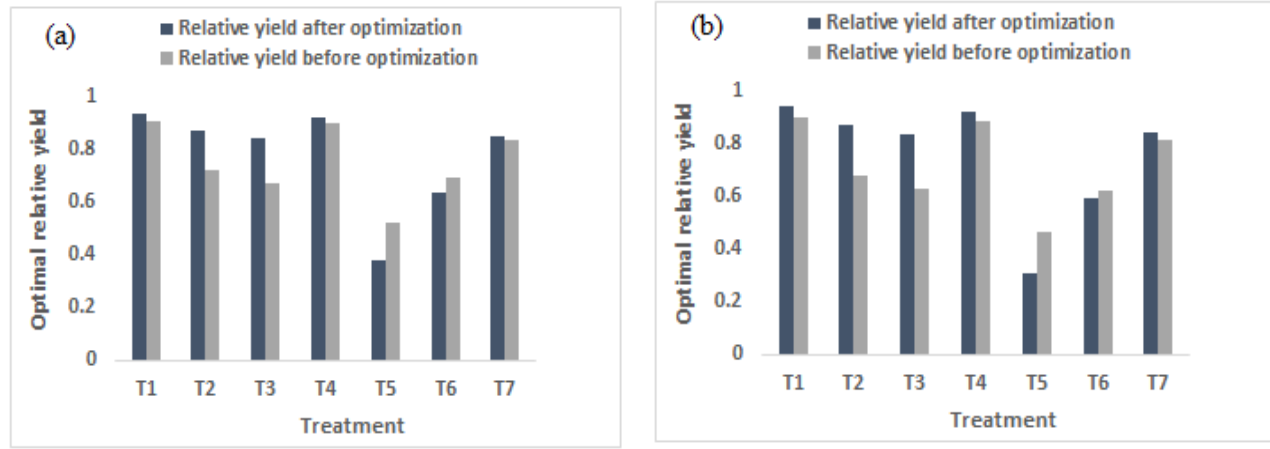
Figure 10. Optimal relative yield before and after optimization: ( a ) potato and ( b ) wheat .